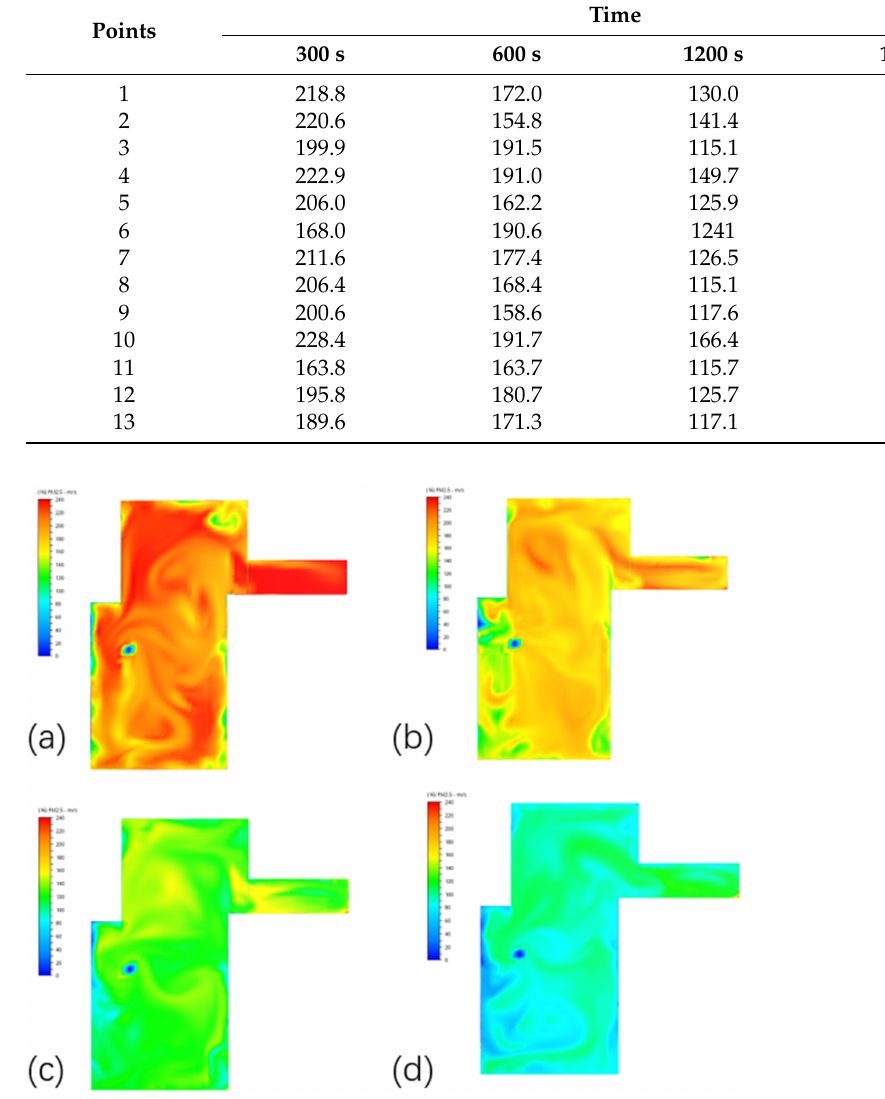
Figure A4. The simulation results of case 5 at the time of ( a ) 300 s; ( b ) 600 s; ( c ) 1200 s; ( d ) 1800 s. Table A4. Quantitative results of case